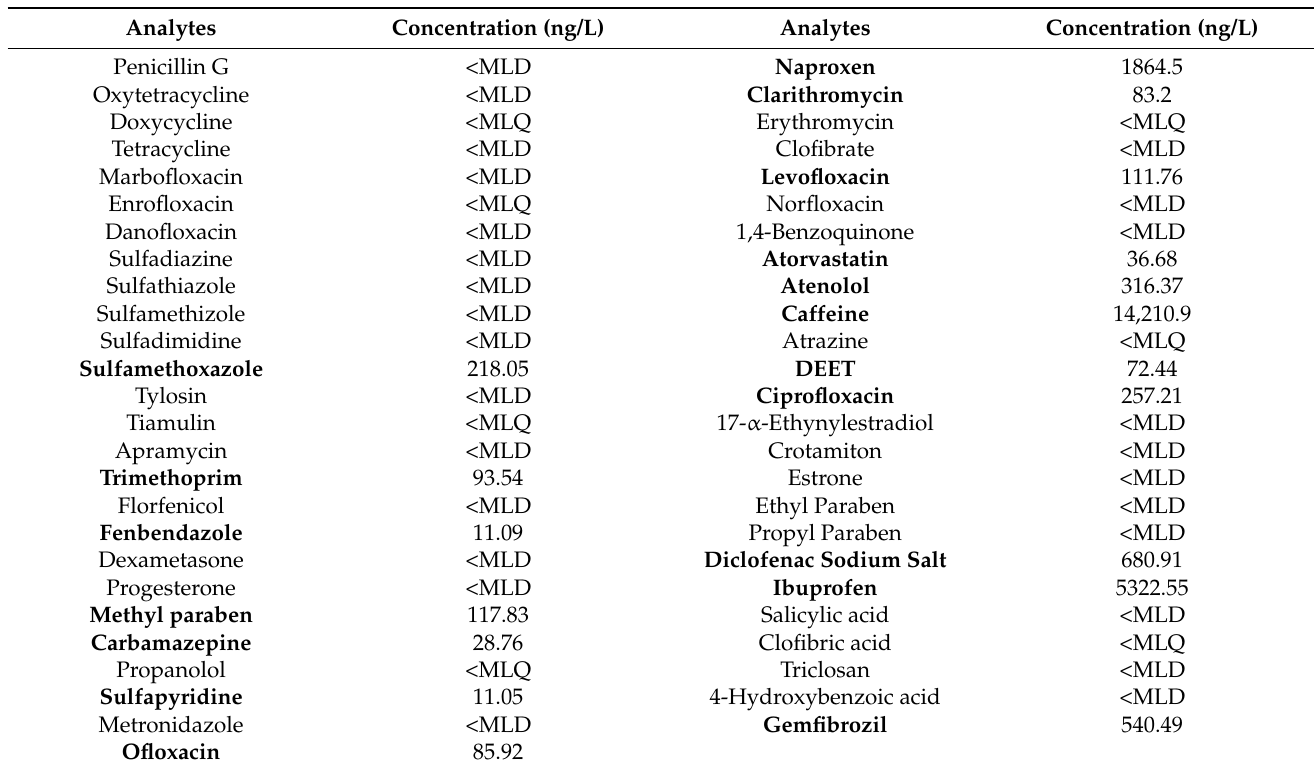
Table 3. Concentrations of contaminants found at the outlet of the desander of the urban WWTP from